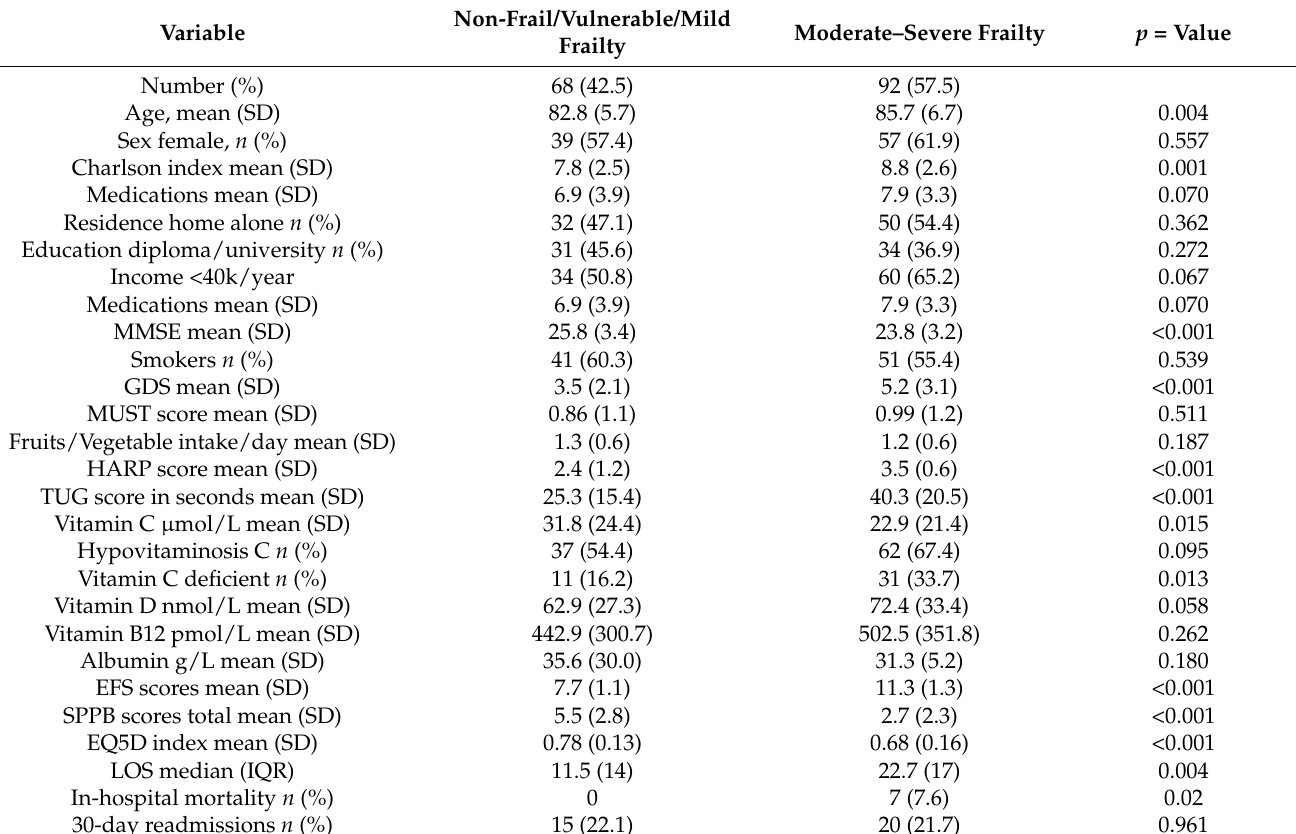
Table 1. Characteristics of vulnerable/mildly frail patients compared to moderate/severely frail patients.